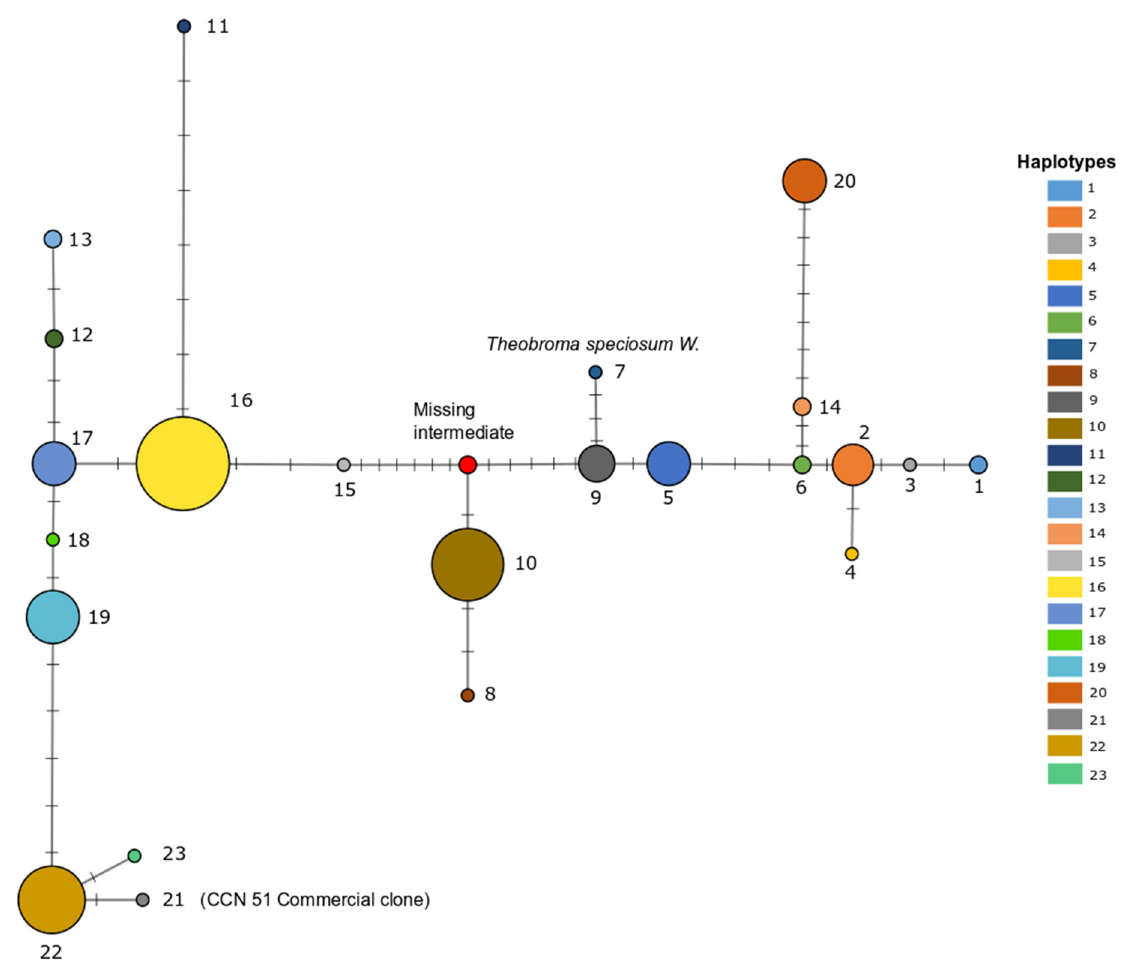
Figure 4. Network of chloroplast haplotypes (1–23) in Theobroma cacao L. populations. Each circle represents a specific haplotype, and its size reflects the respective haplotype frequency. Vertical bars in the lines connecting haplotypes indicate hypothetical mutations separating haplotypes. The distance between neighboring vertical lines is the same, but it was condensed in some linages for better space use and visualization of the network.